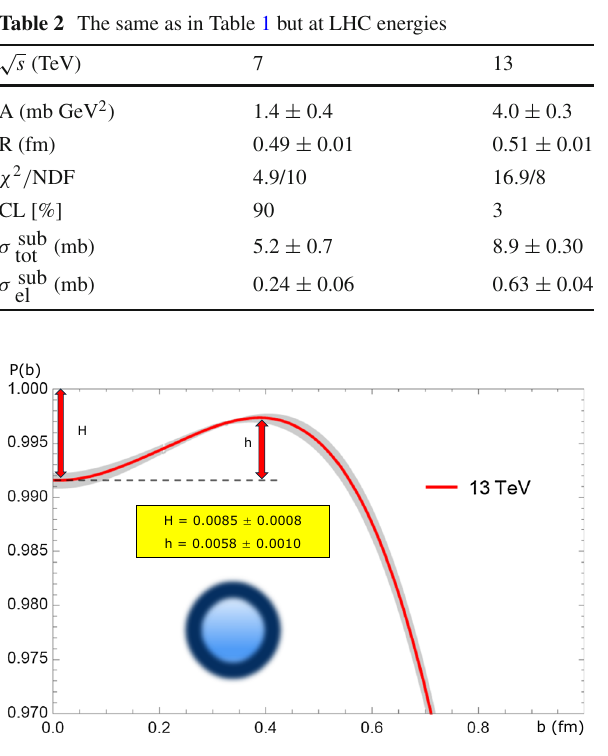
Fig. 4 The inelasticity (or shadow) profile function extracted from the TOTEM 13 TeV data using the Lévy expansion method, together with the associated error bar, zoomed in around the peak value